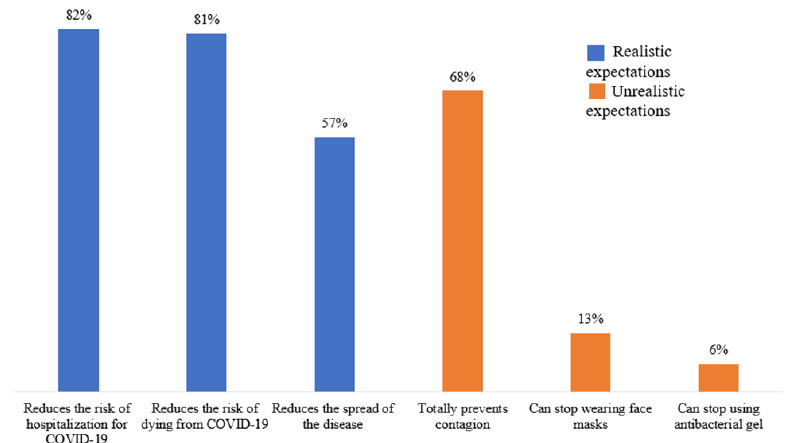
Figure 6. Vaccine’s realistic and unrealistic expectations in patients with diabetes (n = 288). Table 2. Multivariate analysis of the vulnerability, benefits, barriers, self-efficacy, vaccine expectations, and cessation of use of face